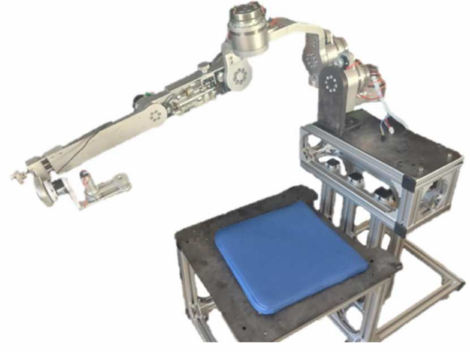
Figure 22. Prototype of 5 R a 1 P